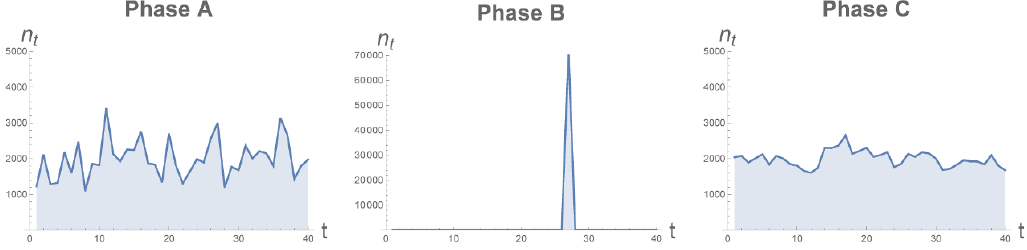
Figure 8 . Typical volume pro(cid:12)les n t (cid:17) N ogy (cid:6) = T 3